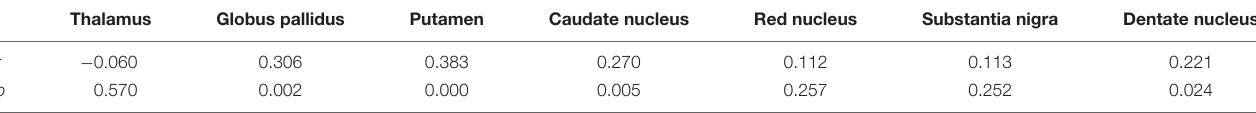
TABLE 4 | The Pearson linear relationship between susceptibility values of DGM and age. Thalamus